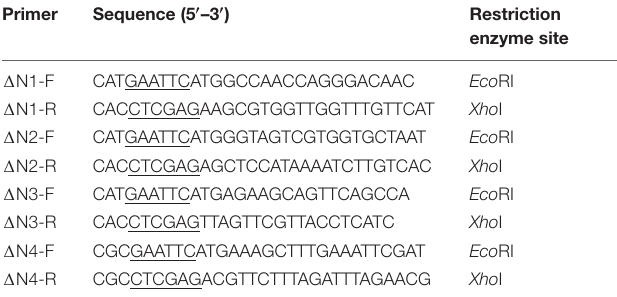
TABLE 2 | Sequences of primers used for cloning the TGEV N-protein deletion mutants. Primer Sequence (5 (cid:48) –3 (cid:48) )